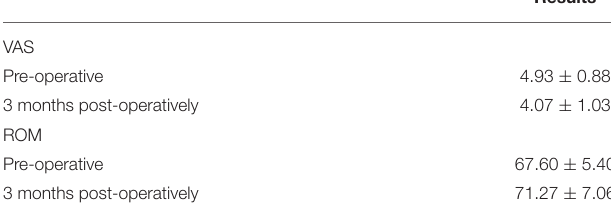
TABLE 2 | Functional